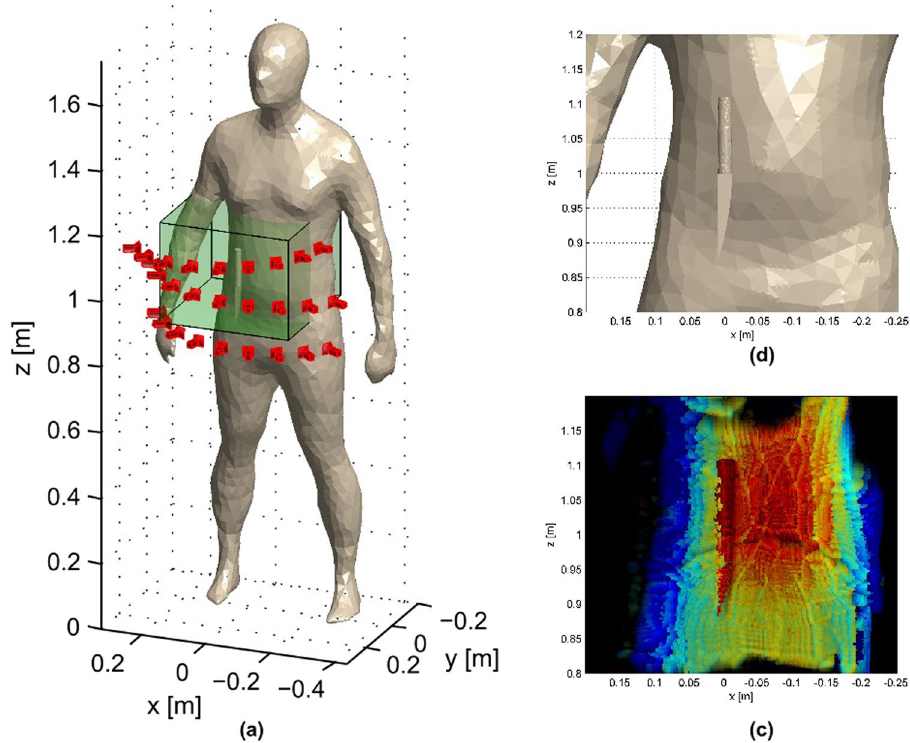
Figure 4. Simulation example comprising 27 scanner positions: ( a ) 3D model, camera positions and reconstruction volume; ( b ) detail of the knife; ( c ) mm-wave image considering all the